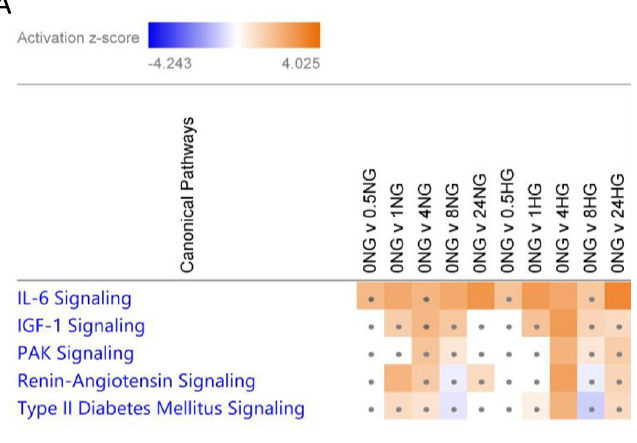
HG treatment causes differential pathway activation/inhibition compared to NG condi‑ tions.